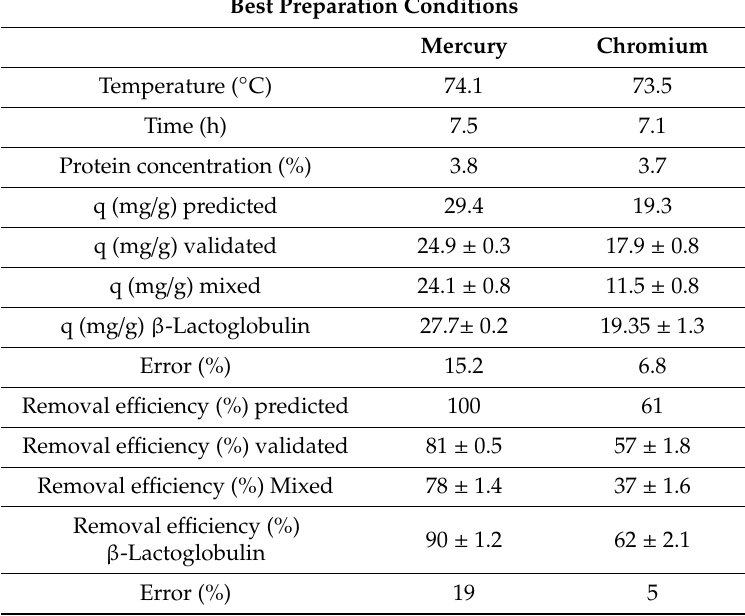
Table 3. Best preparation conditions to produce WPF and to improve the adsorption capacity and removal e ffi ciency for mercury and chromium. Validated values were expressed as mean ± SD of